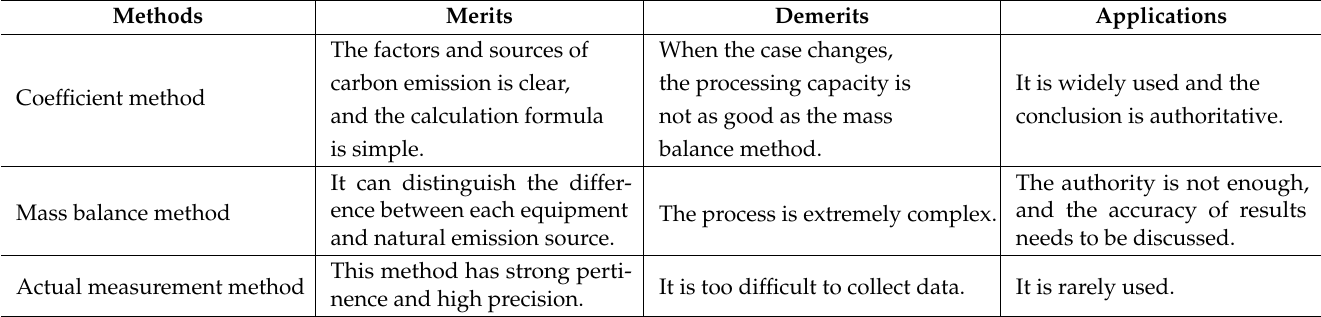
Table 1. Features of General Used Carbon Emission Assessment